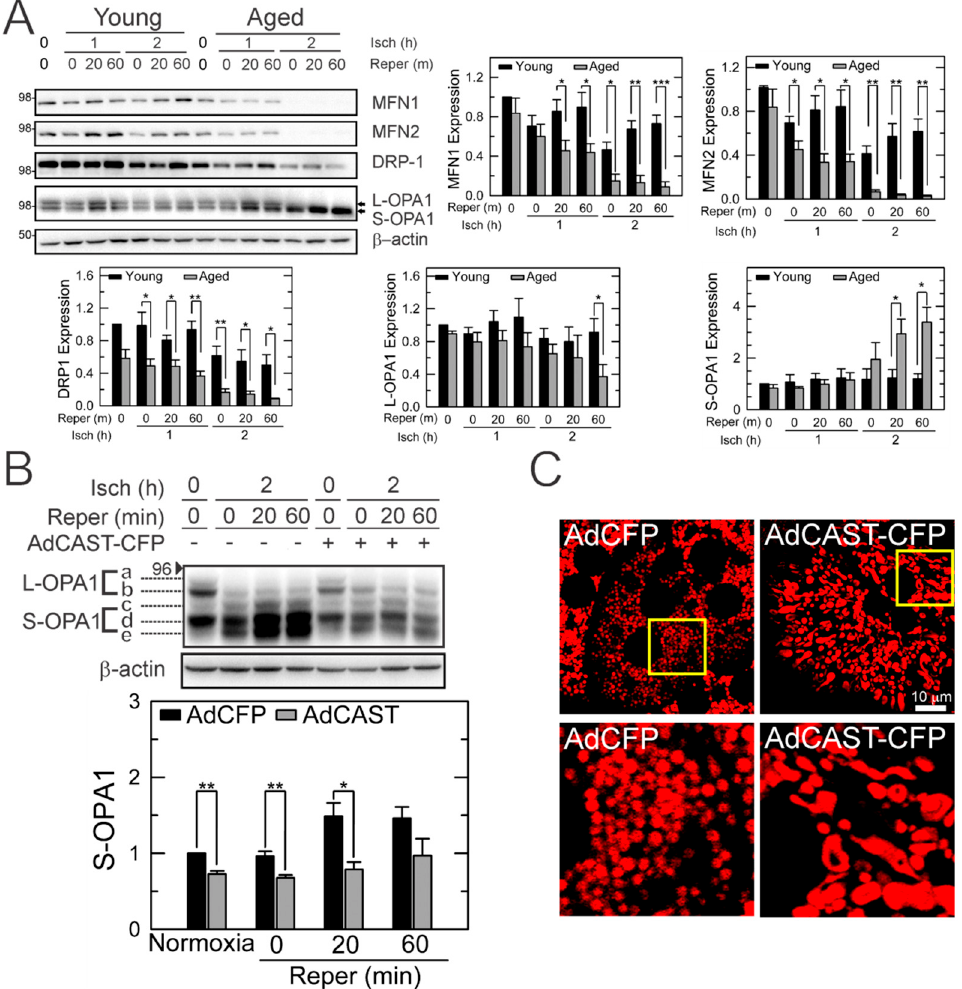
Figure 6. Altered MD in reperfused young and aged hepatocytes. ( A ) IB analysis of proteins related to MD after I/R in hepatocytes from different ages ( n = 3). Changes in individual proteins were expressed relative to their levels in young hepatocytes at normoxia. ( B ) Determination of L- and S-OPA expression in reperfused aged hepatocytes before and after CAST overexpression ( n = 3). Changes in S-OPA1 were expressed relative to its level at normoxia without CAST overexpression. ( C ) Confocal microscopy of TMRM-labelled mitochondria with and without CAST overexpression. Bottom panels represent enlarged images of the square inset in top panels. * p < 0.05, ** p < 0.01 and *** p <